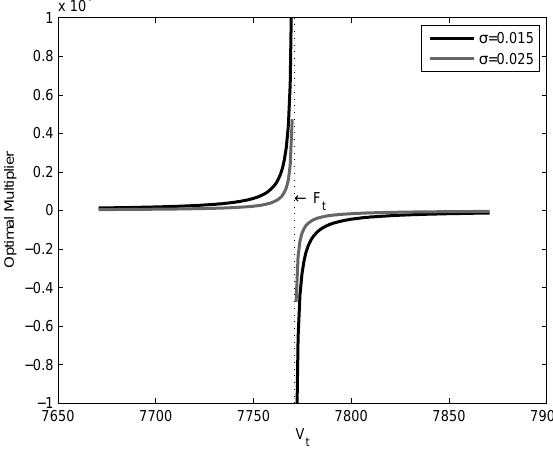
Figure 3. Optimal Multiplier versus Value of the Pension Fund for different values of σ when ( γ =